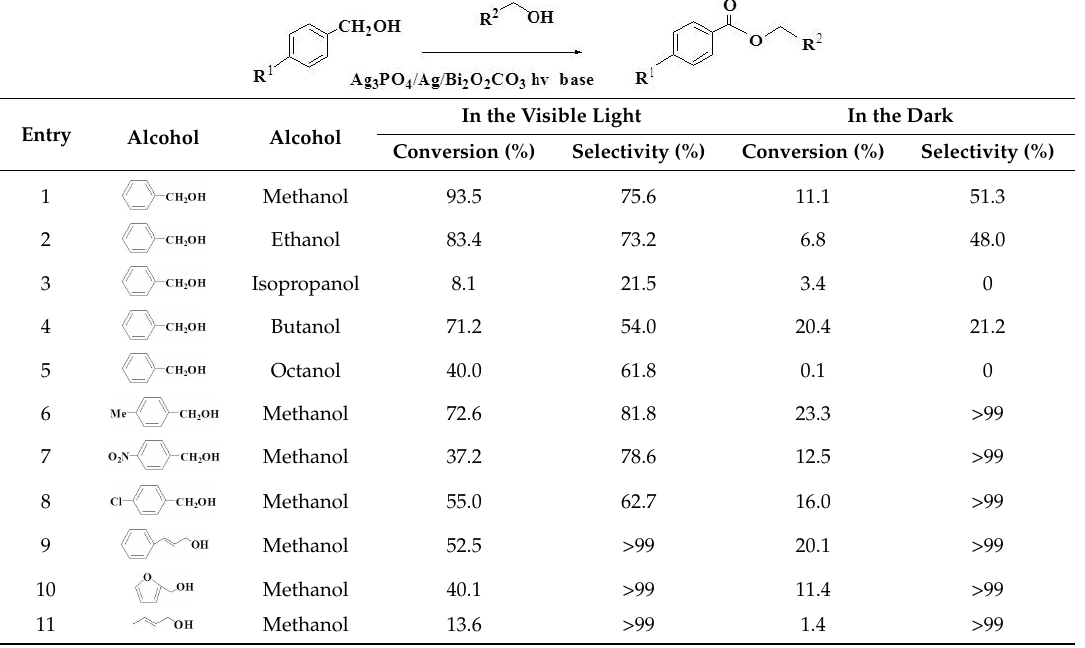
Table 3. Synthesis of esters from different alcohols using 71 wt % Ag 3 PO 4 /Ag/Bi 2 O 2 CO 3 .